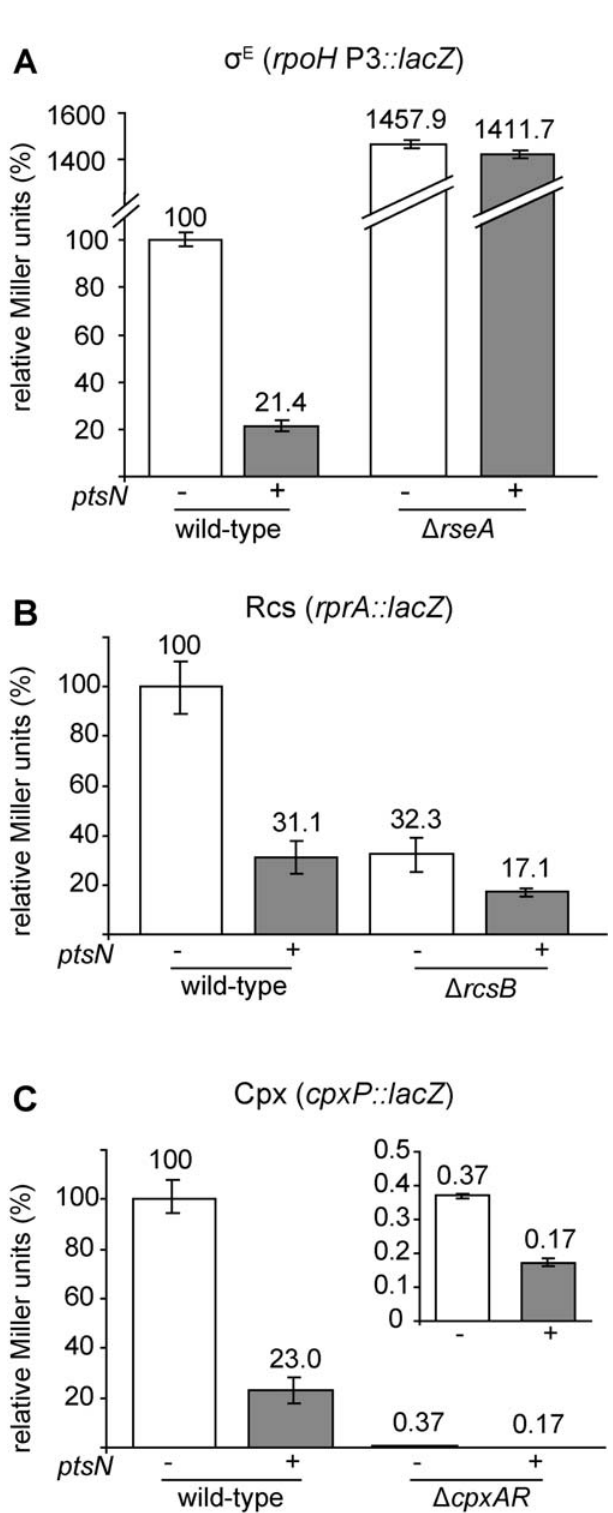
Figure 8. ptsN requires known regulators to reduce stress sensed by the s E , Rcs, and Cpx envelope stress pathways. In each panel the b -galactosidase activity was measured with and without overexpression of ptsN in a WT strain and in a strain lacking known regulators of the respective stress responses. Measurements are expressed as the percentage of reporter gene activity in the WT strain without ptsN overexpression and this value is noted above the columns. Relative reporter gene activities are shown for (A) the rpoH P3-